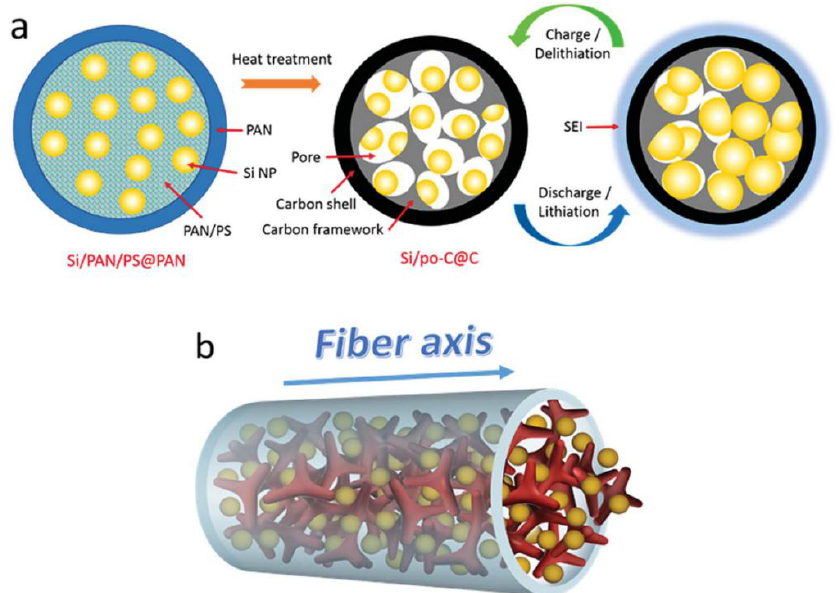
Figure 4. Schematics of the structural design of the core-shell silicon/carbon fiber (Si/po-C@C) composite fiber: ( a ) structural formation and change of Si/po-C@C during heat treatment and cycling process, respectively; ( b ) three-dimensional (3D) sketch of the overall structure. (SEI: solid-electrolyte interphase). Reproduced with permission from [82]. Copyright Royal Society of Chemistry, 2015.